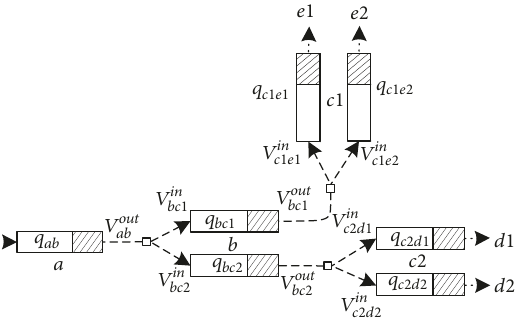
Figure 7: The relationship of arrival and departing vehicle flow in traffic